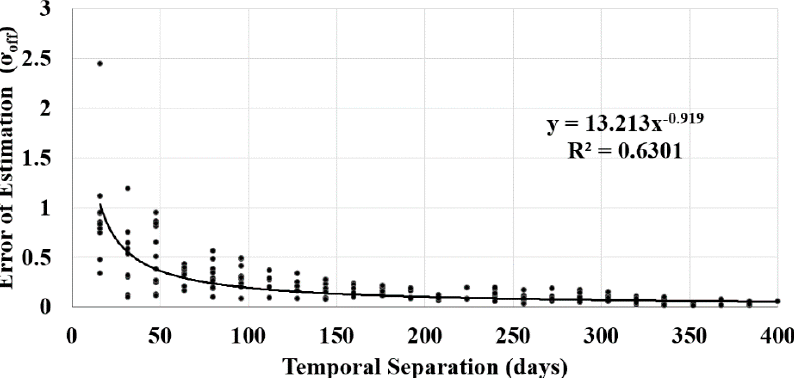
Figure 3. Error of Estimation ( σ of f ) on retrievals of glacier surface flow velocity for L8/OLI optical images vs. temporal separation of paired images .